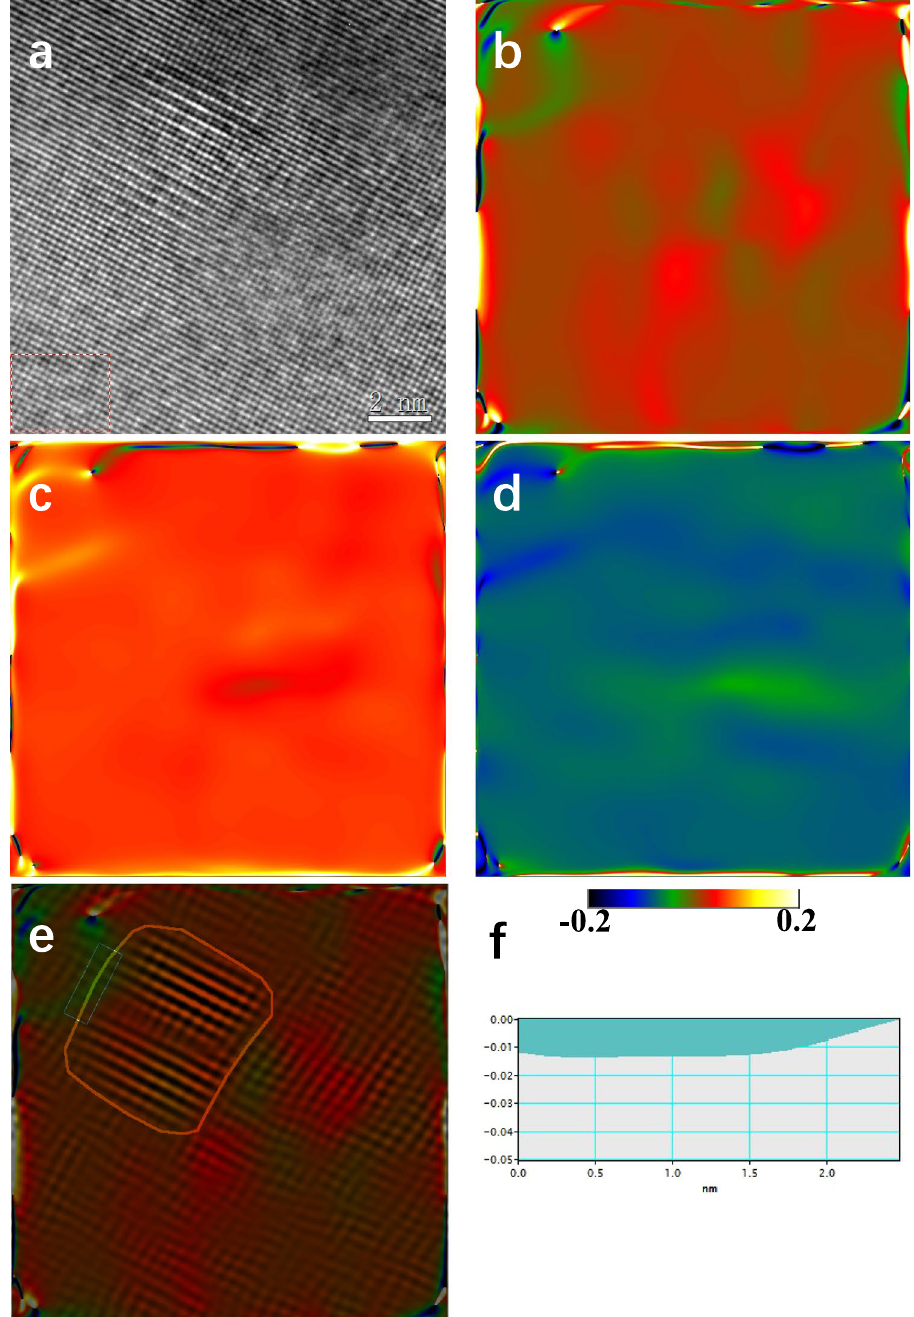
Figure 6. Geometrical phase analysis (GPA) of a coherent Al 3 Zr precipitate in the III-type-265 Al-Zr conductor. ( a ) A representative HRTEM image to show a coherent Al 3 Zr precipitate. Corresponding GPA results demonstrating the local ε strain field ( b ), ε strain field ( c ), and ε strain field ( d ). ( e ) Is a picture xx yy xy overlapping the GPA ε strain field with the HRTEM image, where the Al 3 Zr precipitate/matrix interface is xx highlighted by a loop line. ( f ) Shows the distribution of ε in a profile that was measured along a segment xx (as marked by green box in ( e )) of the Al 3 Zr precipitate/matrix